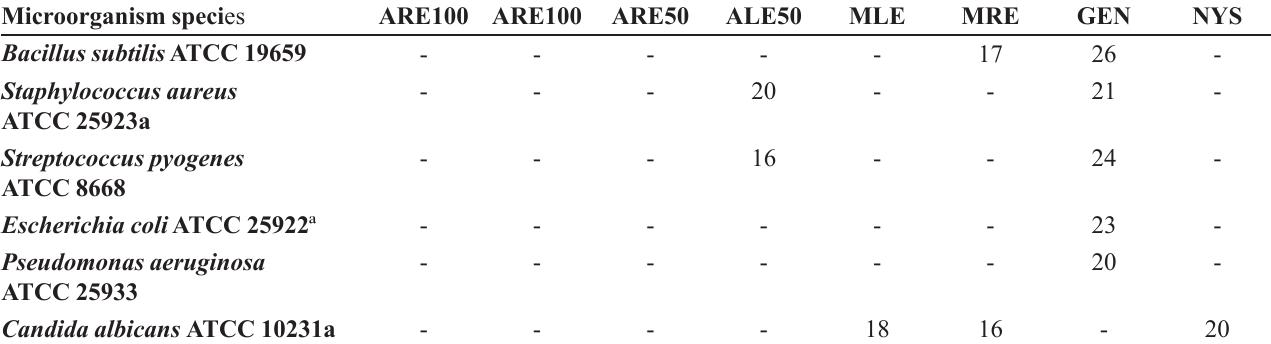
TABLE I - Antimicrobial activity of G. manicata extracts 25 mg mL -1 (inhibition zones in diameter (mm)) Microorganism speci es